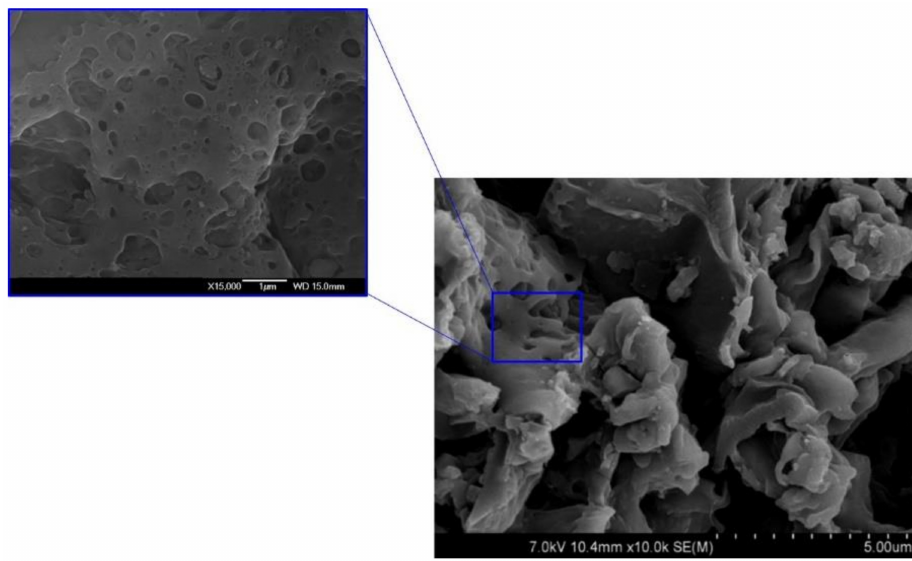
Figure 4. Field emission scanning electron microscopy (FE-SEM) image for the AC. A higher magnification micrograph is shown in the inset.